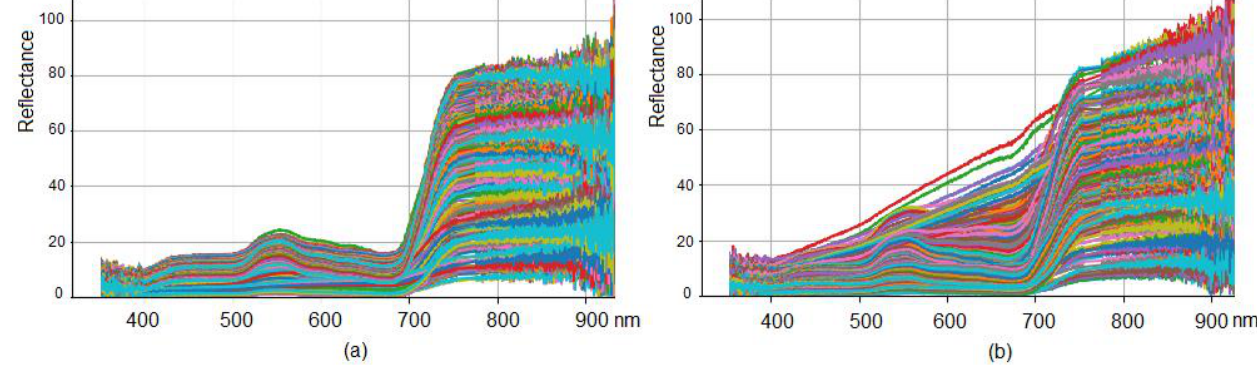
Figure 3. Hyperspectral curves of one dataset after preprocessing of raw data (each chart includes 2000 curves): ( a ) curves of healthy leaf, ( b ) curves of leaf in medium stage of Septoria disease.